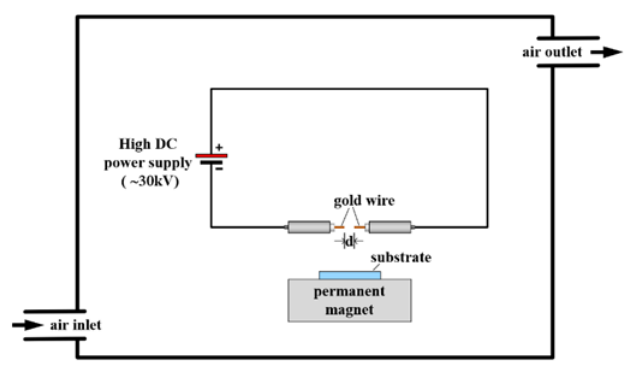
Figure 1. Experimental setup; high DC voltage is discharged from capacitor 24 nF.